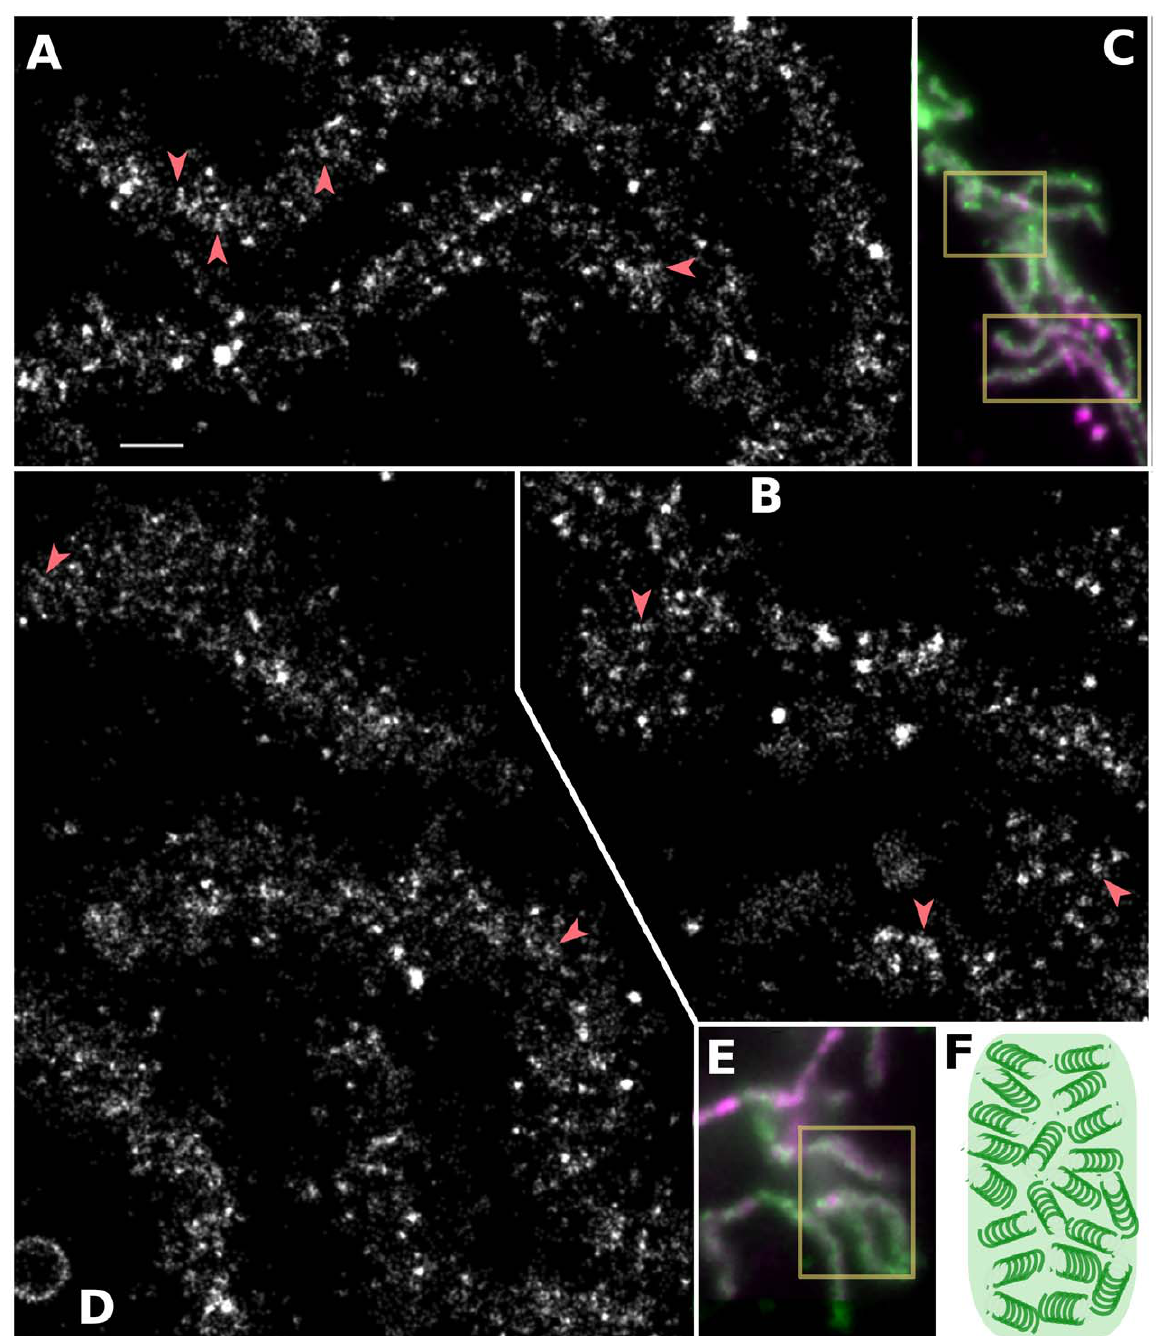
Figure 3. Drosophila Metaphase Chromosome Arms Consist of Fine Chromatin Fibers. (A, B) PALM reconstruction of chromosome arms boxed in (C) free from cytoplasm. (D) PALM reconstruction of chromosome arms boxed in (E) surrounded by the cytoplasm. Red arrowheads point to typical filamentous structures, although this structure is almost everywhere in the chromosome arms. (C, E) Denoised wide-field images of chromosomes. DAPI staining is shown in purple and H2AvD-EGFP is shown in green. Bar shown in (A) corresponds to 0.5 m m in (A, B, D) and 3 m m in (C, E). (F) A schematic drawing of the metaphase chromosome arm based on the interpretation of the PALM reconstruction.